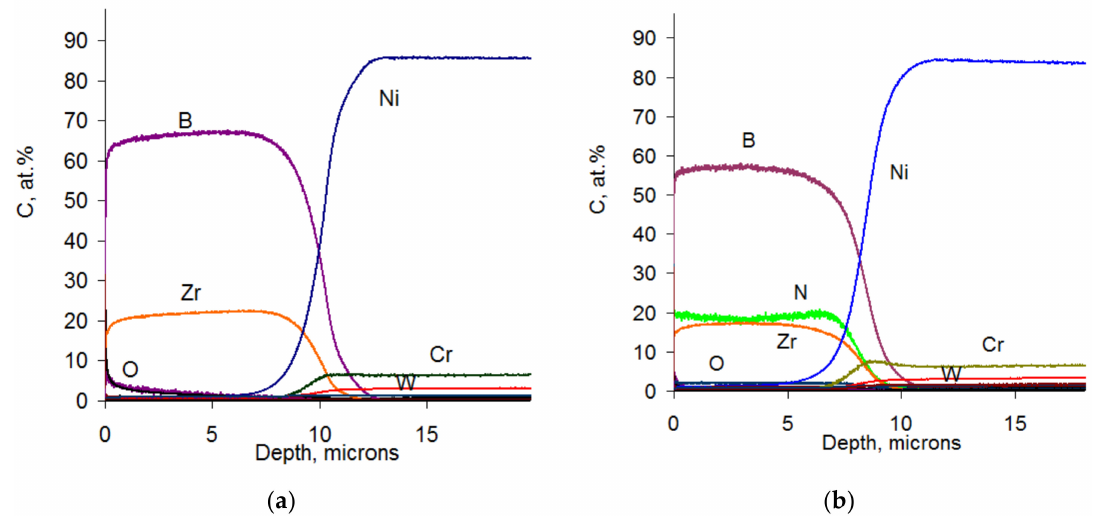
Figure 1. GDOES profiles for the coatings 1 (100%Ar) ( a ) and 2 (85%Ar + 15%N 2 ) ( b ). The concentration of admixtures of carbon and oxygen did not exceed 1.5 at.% per ele- ment. The presence of the admixtures in the coatings can be attributed to the trace amounts of carbon and oxygen both in the sputtered target and in the sputtering atmosphere. The depth-averaged concentration of the main constituent elements is presented in Table 1. Table 1. Composition, mechanical properties and tribological performance of the coatings. Composition, № Atmosphere